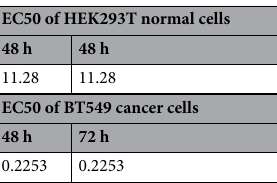
EC50 of HEK293T normal